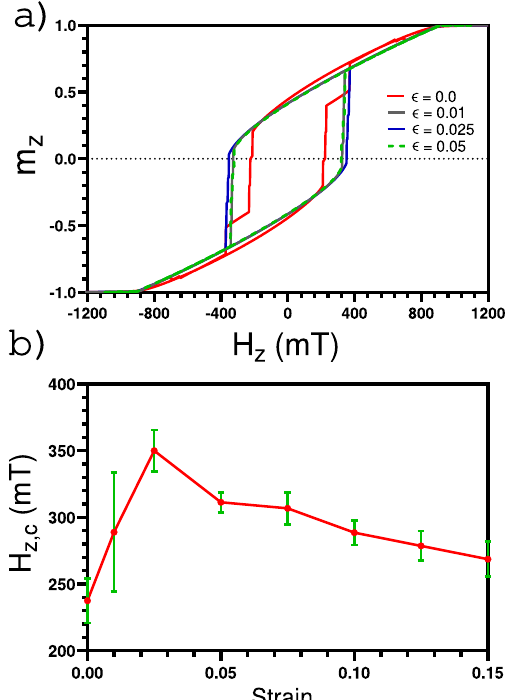
Figure 4. ( a ) Histeresis curve at different strain. ( b ) Coercivity as a function of a strain.